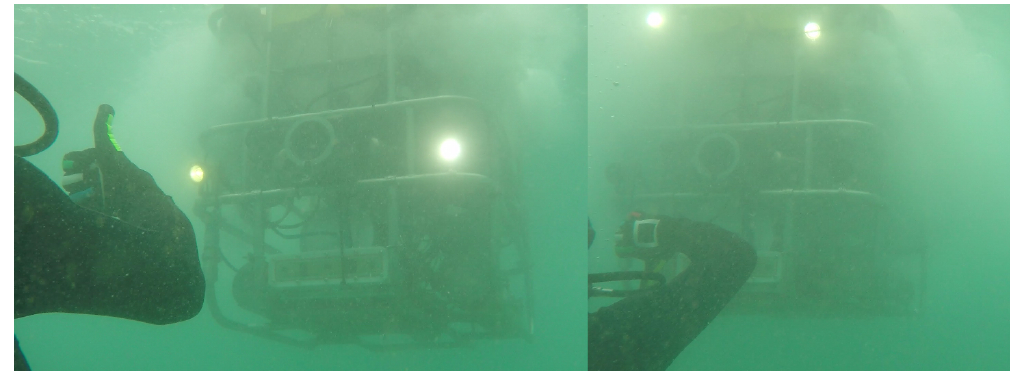
Figure 9. CADDY simple gesture recognition in a harsh underwater